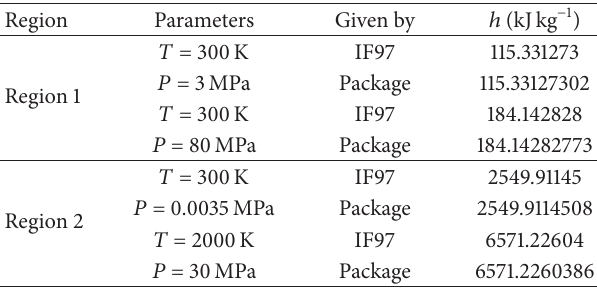
Table 1: Comparison of calculation results between package sub- routine and IAPWS-IF97. Region